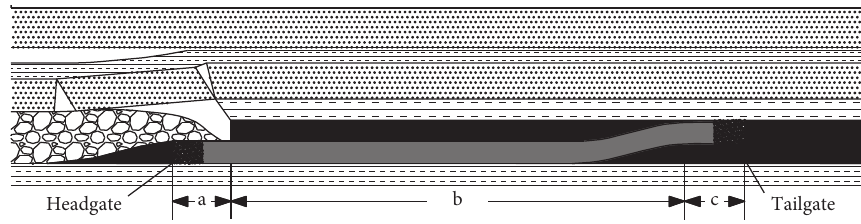
Figure 21: Triple sections mining operation (TSMO) of SLL